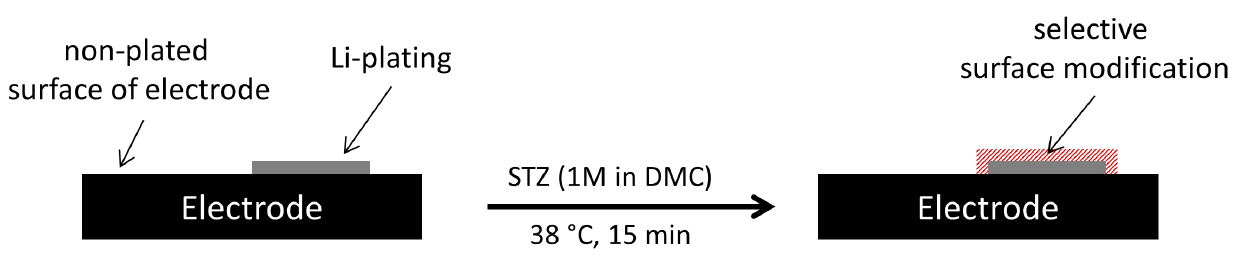
Figure 4. Schematic surface modification